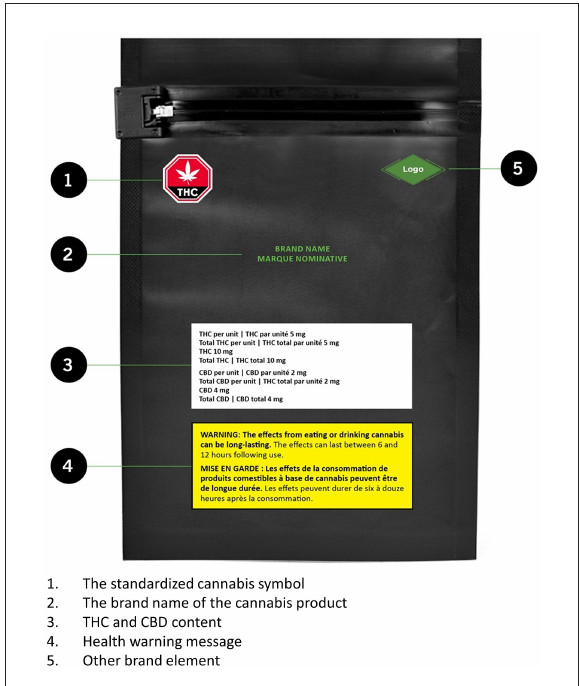
FIGURE1 The anterior side of cannabis packaging in Canada. Source: ©All rights reserved. Packaging and Labelling Requirements. Health Canada, modified 2019. Adapted and reproduced with permission from the Minister of Health, 2021.